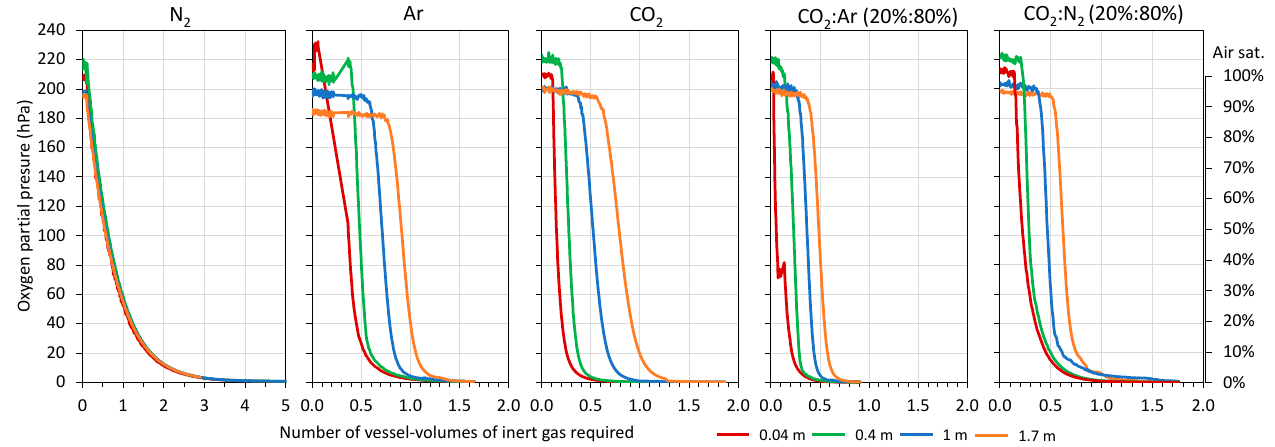
Figure 4. Monitoring of oxygen content during purging of the empty destination tank with different gases.